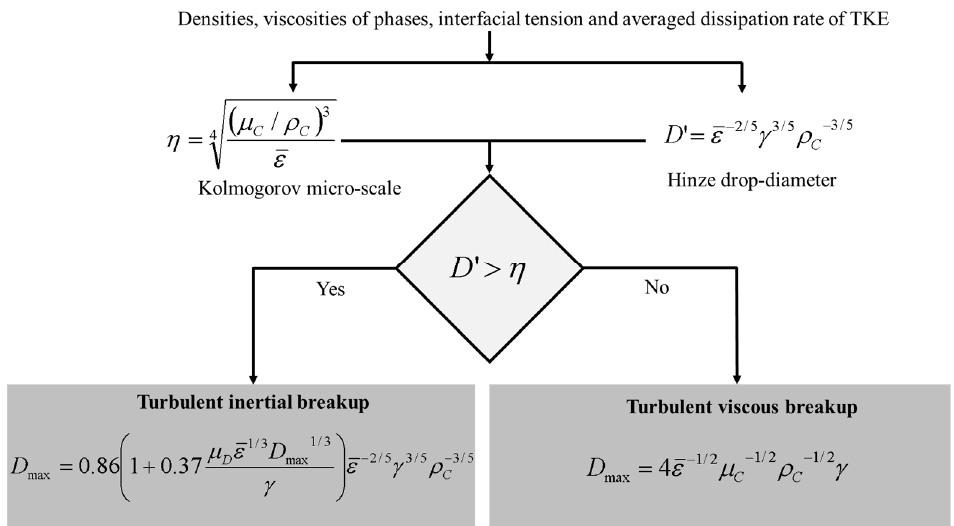
Figure 4. Flowchart representation of the drop-viscosity-corrected Kolmogorov–Hinze framework (freely after the algorithmic interpretation first suggested in [9]).